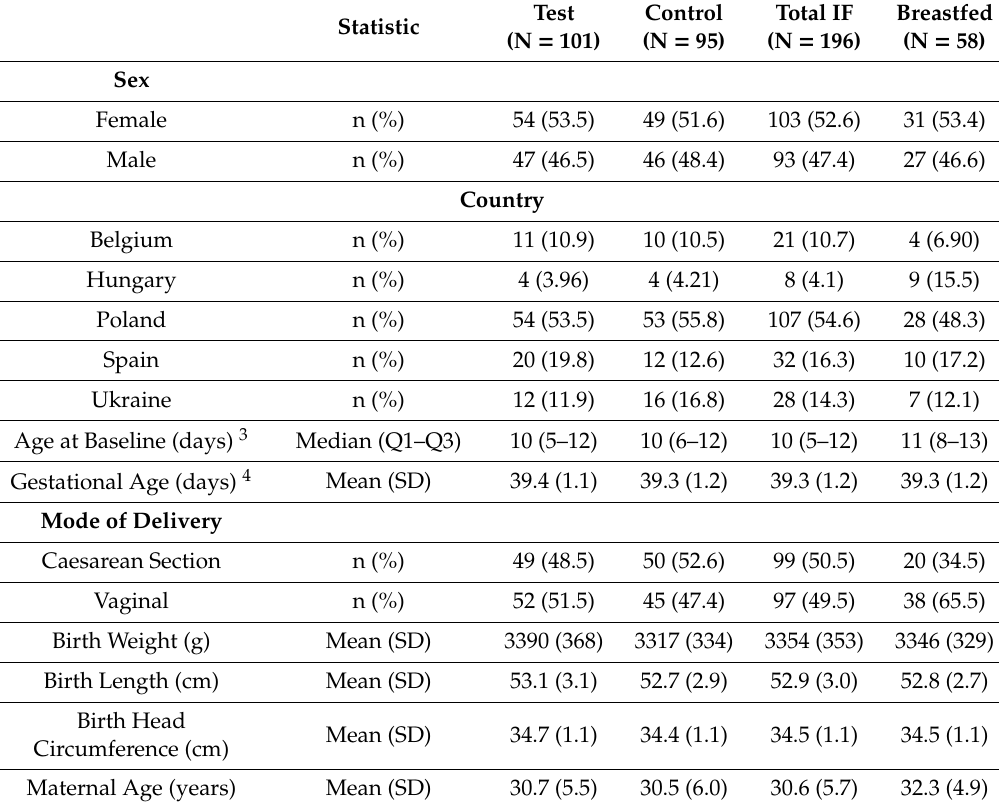
Figure 1. Flow diagram of participants through the study from enrolment to study completion for the All Subjects Treated, Completed, and Per Protocol populations. Completed refers to infants who remained in the study for the entire intervention period without early termination. The per protocol population was evaluated on the visit level and included all infants who met all inclusion criteria, including having at least one post-baseline weight measurement, and consumed only the study product during the intervention (i.e., no commercial infant formula, no complementary / weaning foods) for infants in the randomised groups, or were fully Breastfed for infants in the reference group. Table 2. Infant and family characteristics per group 1,2